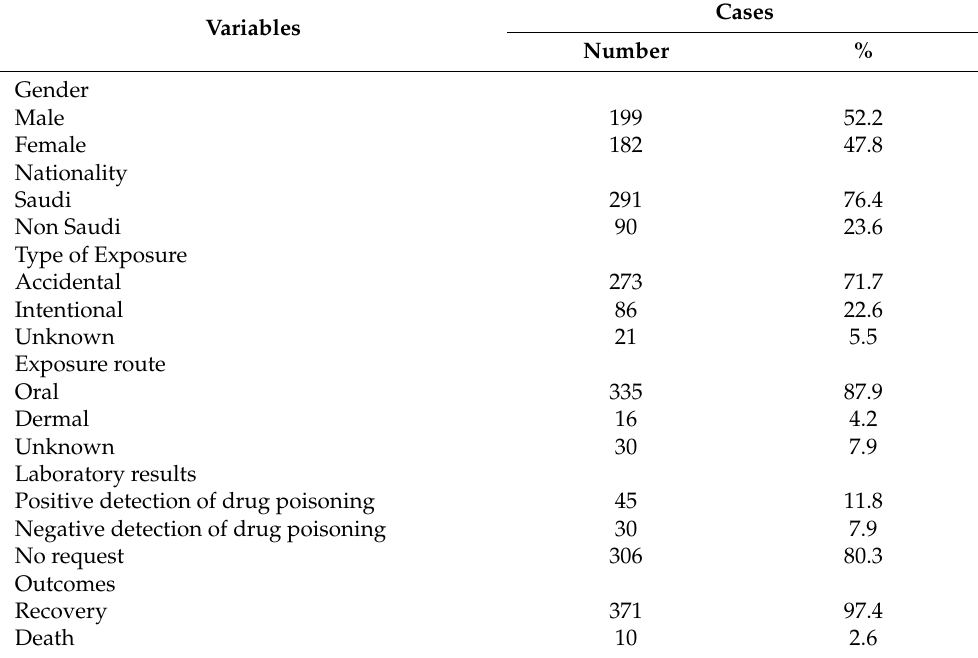
Table 1. Characteristics of chemical poisoning cases according to the study variables.